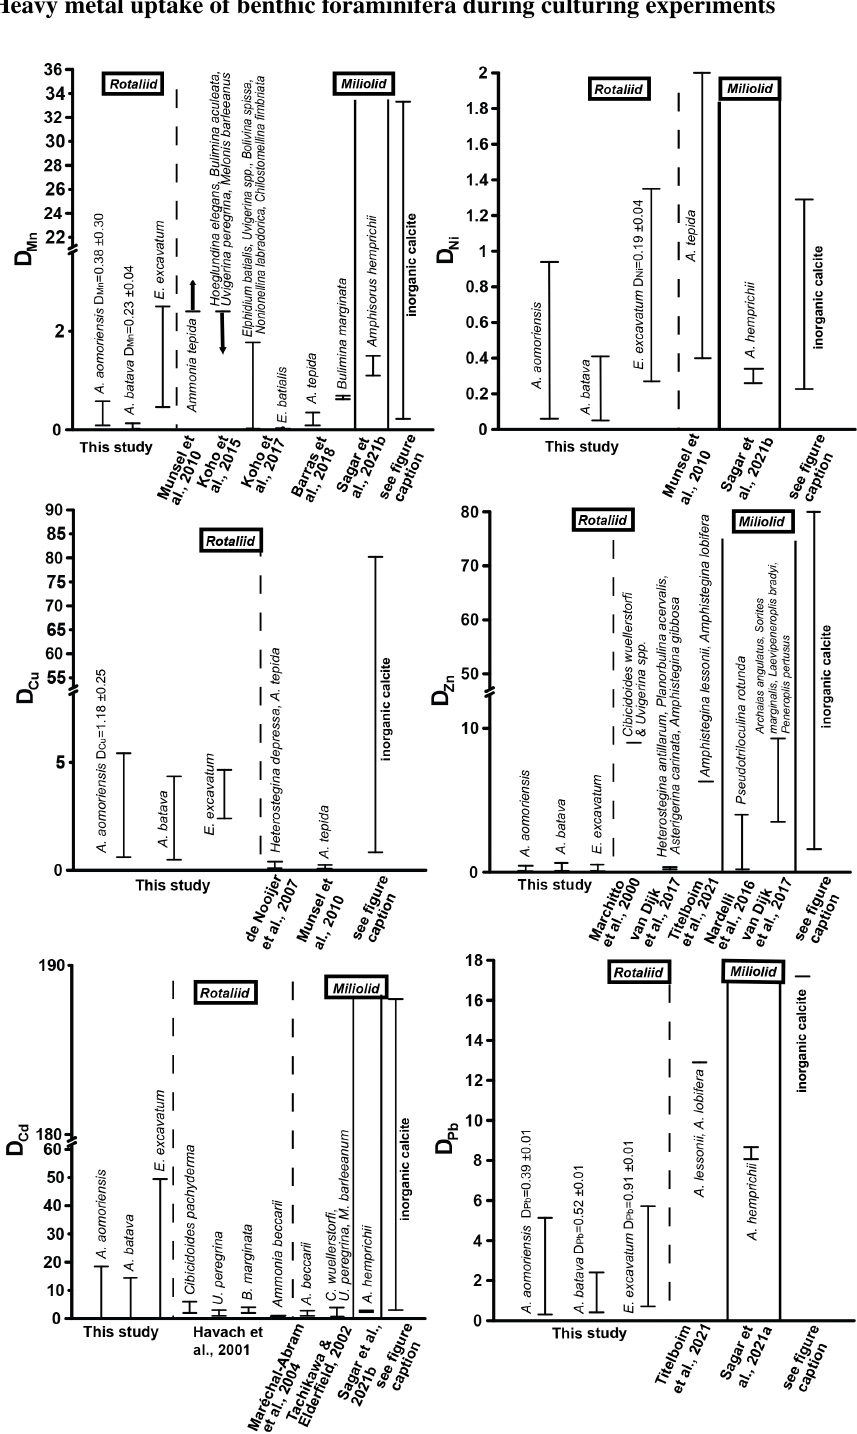
Figure 5. Comparison of D TE values of this study with D TE values from the literature of different rotaliid and miliolid foraminiferal species. The range of D TE values based on the different culturing phases is given, and if a correlation between the heavy metal concentration in seawater and the foraminiferal shell was detected, the mean D TE value ± SD (i.e. slope of the regression line) is also indicated. Note that the x axis is clipped for some elements. (Literature for inorganic calcite D TE values: Ni – Rimstidt et al., 1998; Alvarez et al., 2021; Mn